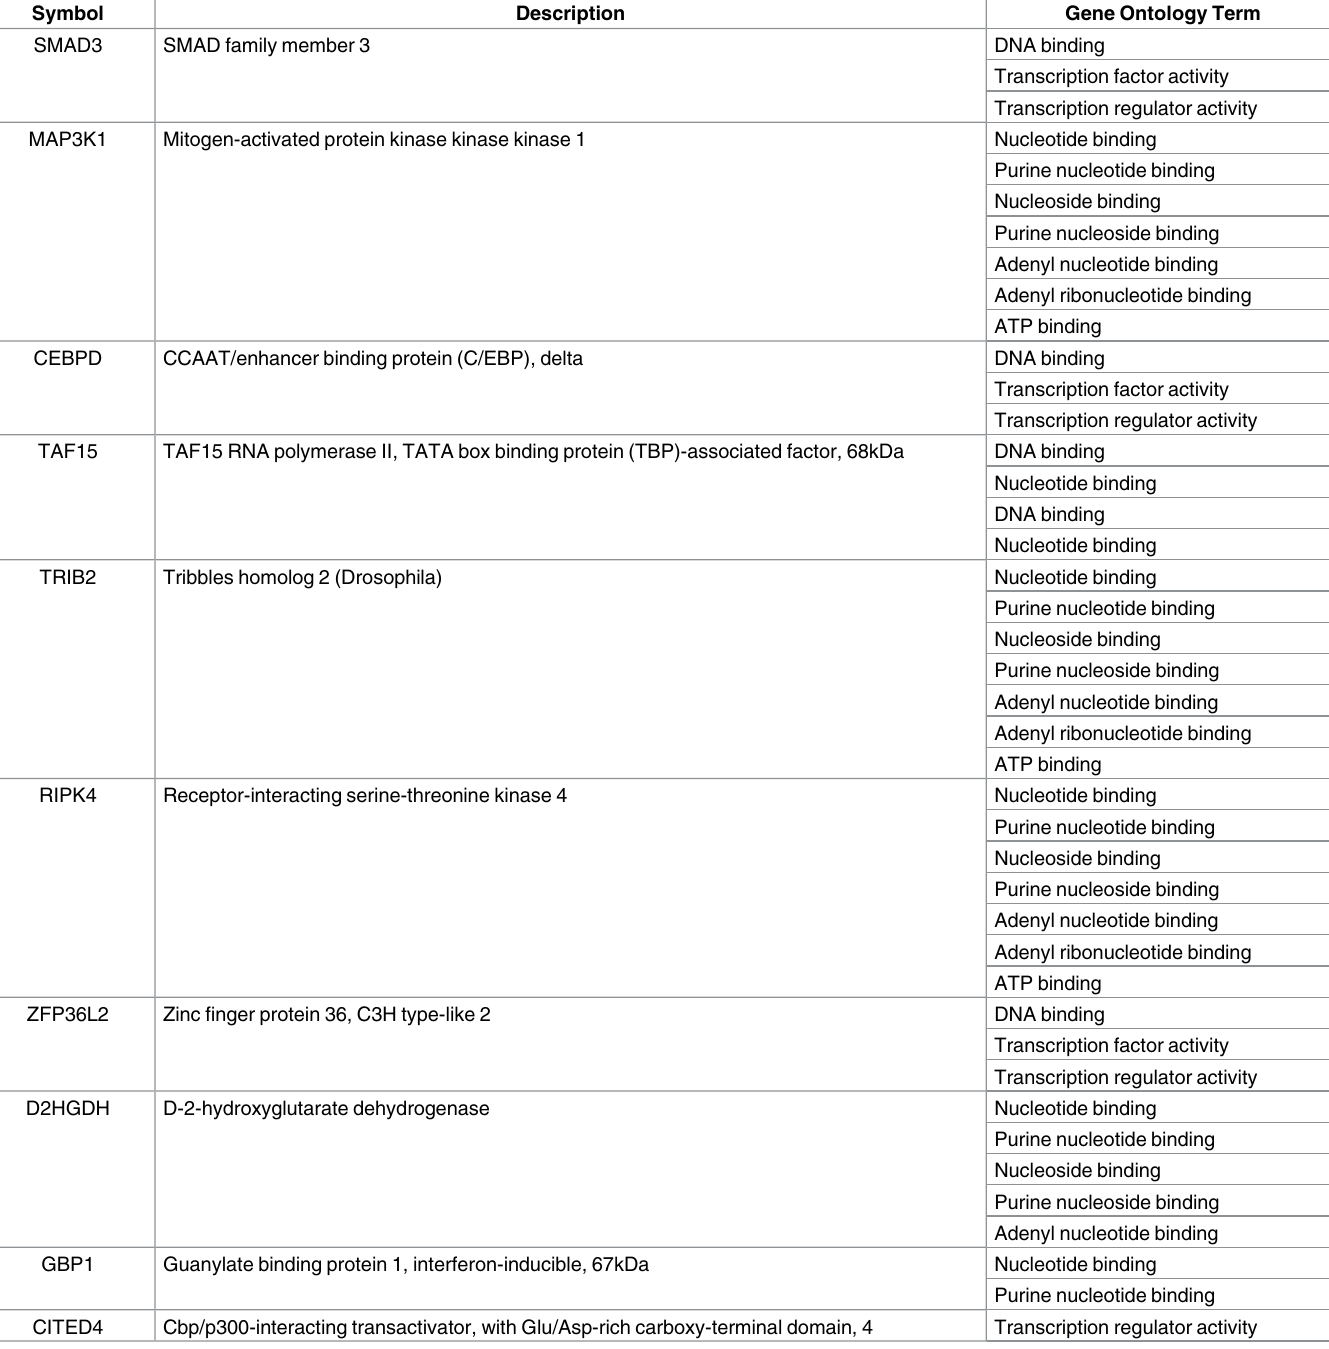
Table 4. The 10 most down-regulated genes found with MF analysis following GE